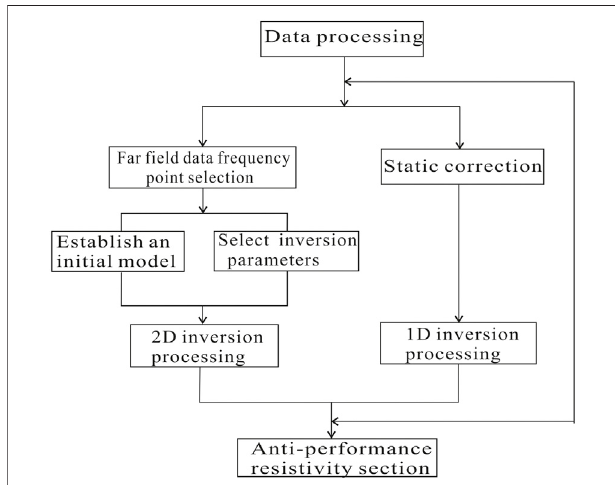
FIGURE 2 | CSAMT data processing fl